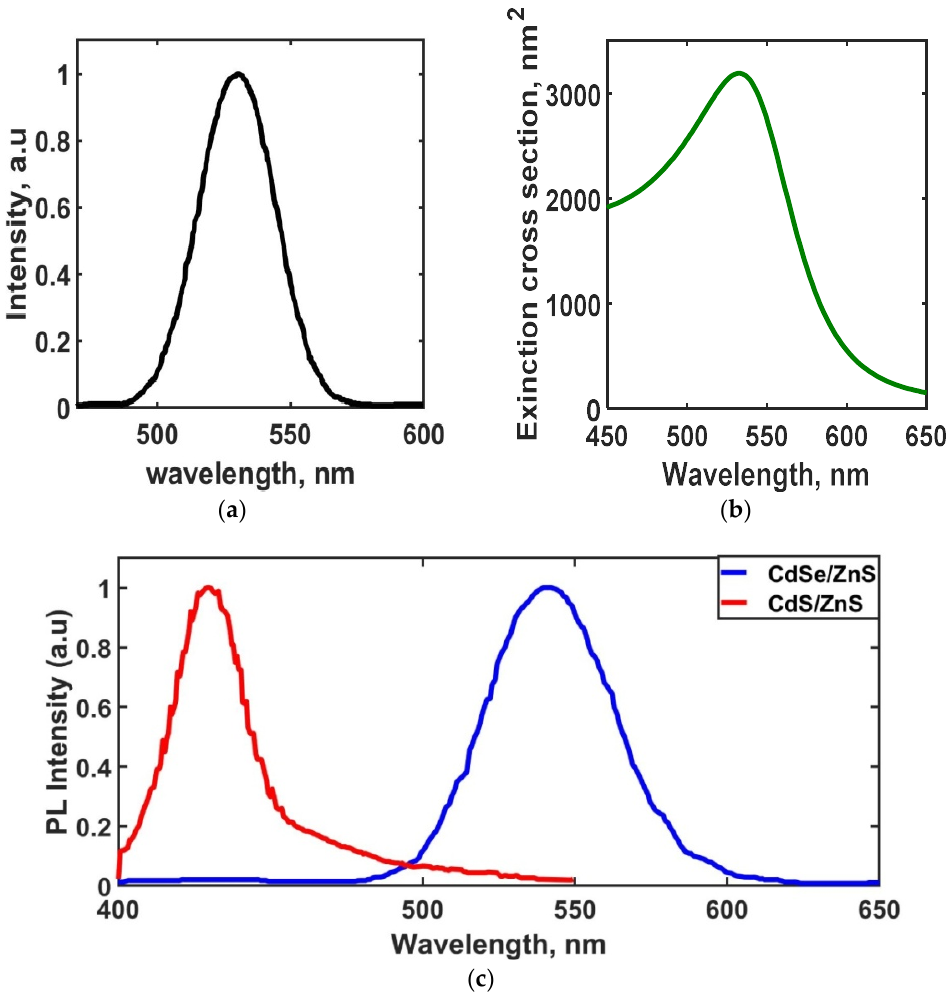
Figure 1. ( a ) Fluorescence emissions intensity of ceria nanoparticles with no added plasmonic nanostructures under 430 nm excitation, and absorption spectra for ( b ) gold nanoparticles with a plasmonic resonance wavelength of around 530 nm, ( c ) CdS / ZnS with a plasmonic resonance wavelength of around 430 nm, and CdSe / ZnS quantum dots showing the plasmonic resonance wavelength at around 530 nm.